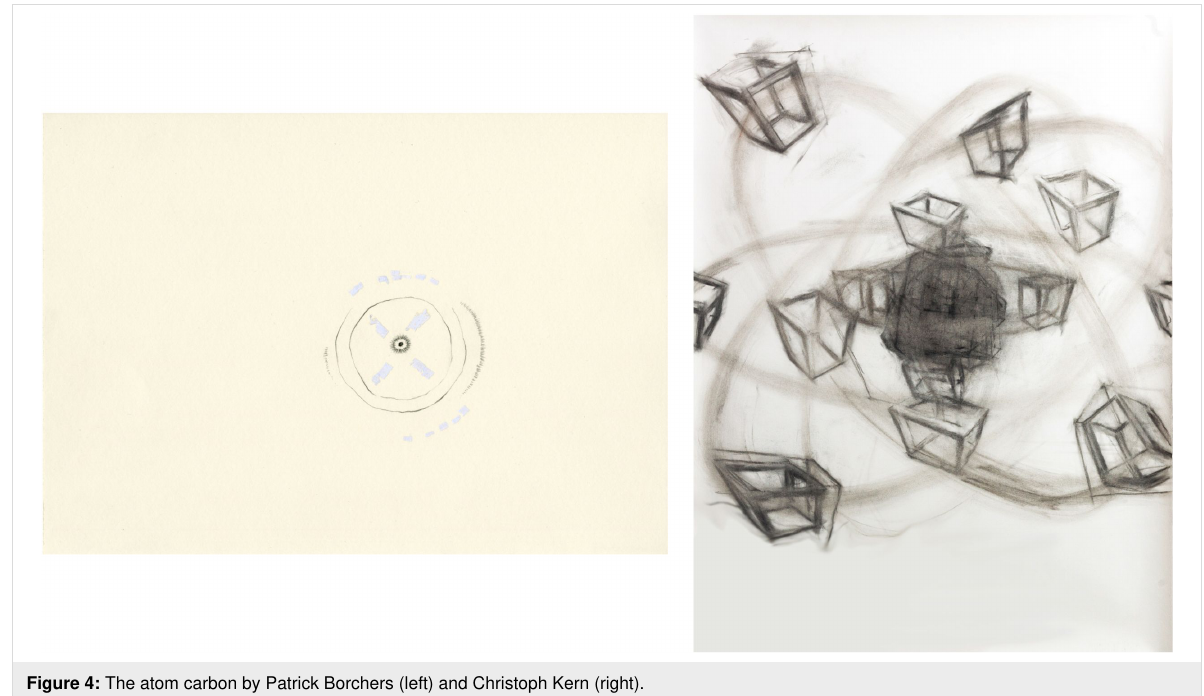
Figure 4: The atom carbon by Patrick Borchers (left) and Christoph Kern (right).